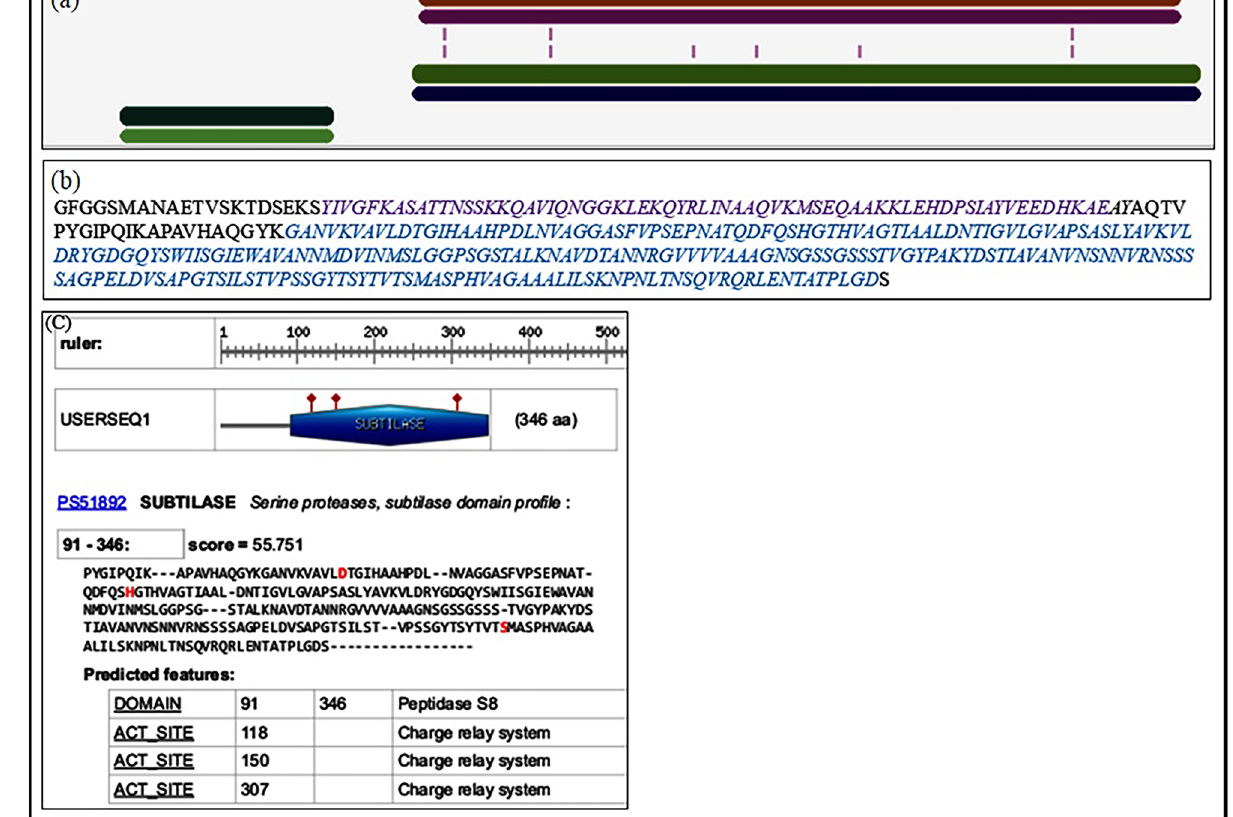
Figure 6. Analysis of domains and active site region of Apr-BO1. This protease showed two domains after InterPro Scan. ( a ) These domains are inhibitor 19 (ranging from amino acid residue 21–84) shown in purple and peptidase S8 domain (from 109 positions to 345th residue) represented in blue. ( b ) The subtilase ranges from 91 to 346 amino acids, and it is known that the S8 family possess a catalytic triad composed of